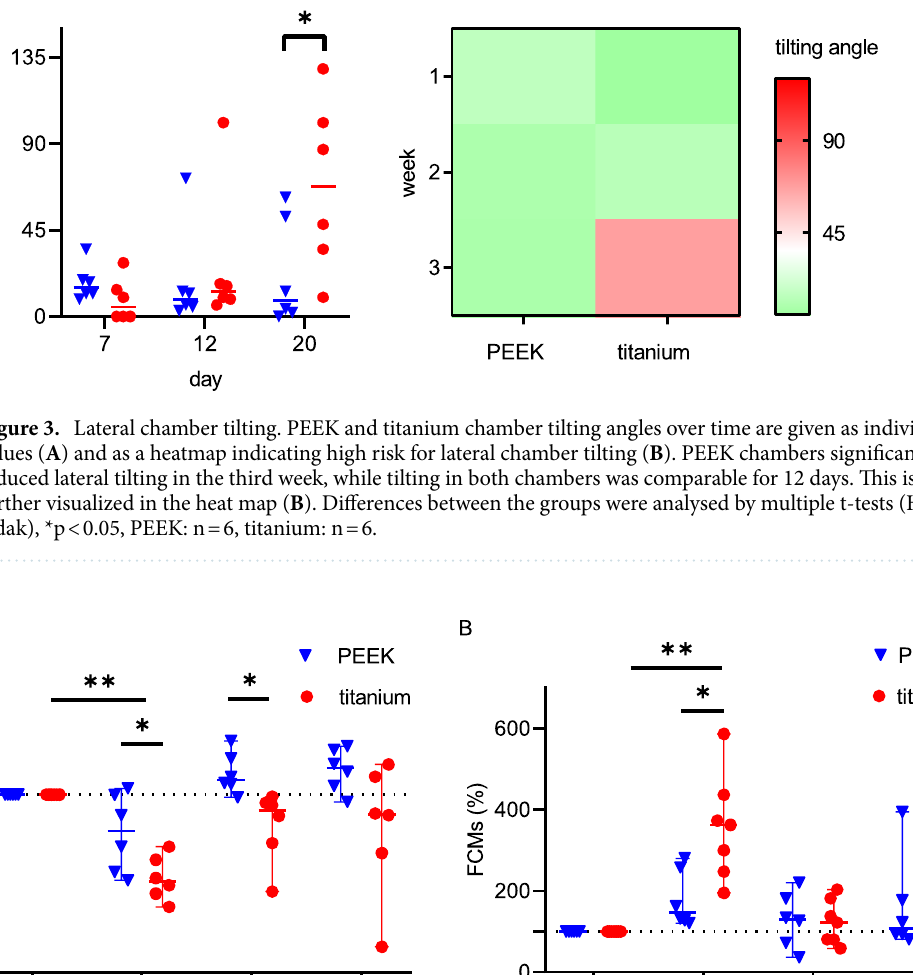
titanium: 368%/248–587%, p < 0.05), while FCMs were comparable in the middle (PEEK: 130%/37–220%; tita- nium: 101%/59–203%, p = 0.31) and late phase (PEEK: 108%/81–395%; titanium: 90%/54–196%, p = 0.85). Specific distress scoring and burrowing assessment did not show differences between titanium and the PEEK chambers (Fig. 5). Distress values remained low, with maximum 7/66 points for PEEK and 6/66 points for titanium chambers (p > 0.8268). In both groups, the distress score increased slightly in the early phase and declined in the middle and late phase. Likewise, burrowing started with relatively high baseline values (PEEK: 108 g/57–195 g; titanium: 196 g/105–200 g, p = 0.06). Postoperative burrowing decreased significantly in both groups (PEEK: p < 0.05; titanium: p = 0.05, vs. baseline). Burrowing remained decreased markedly throughout the observation time in both groups (PEEK: 61 g/13–192 g; titanium: 36 g/20–56 g). In summary, the PEEK chamber is easily available and maintains the high quality of intravital vascular imaging. The PEEK chamber’s flat and lightweight design can reduce animal distress and prolong the maximum duration of the experiment.